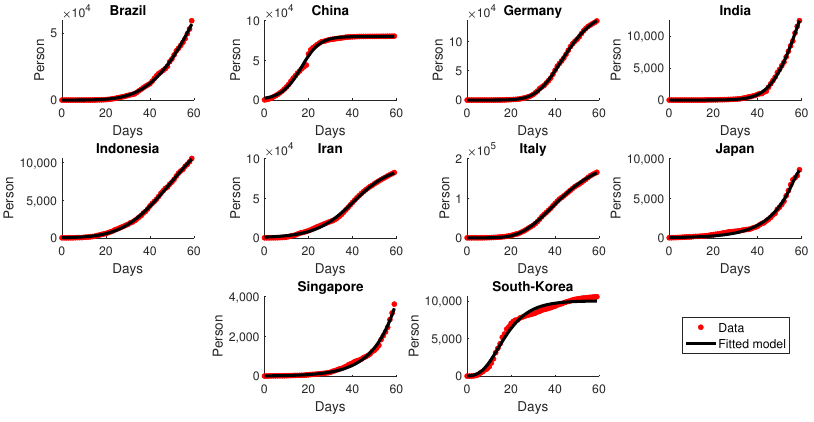
Figure 4. Fitting results ¯ K of cumulative data for several countries in the early pandemic. The red dots represent the actual data, and the solid black lines represent the fitted model ¯ K